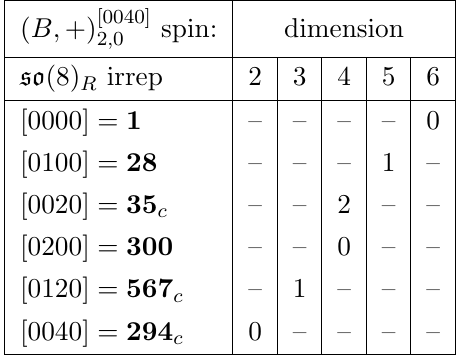
Table 20 . All possible conformal primaries in S 2 (cid:2) S 2 and S 3 (cid:2) S 3 corresponding to the ( B; +) [0040] superconformal multiplet.